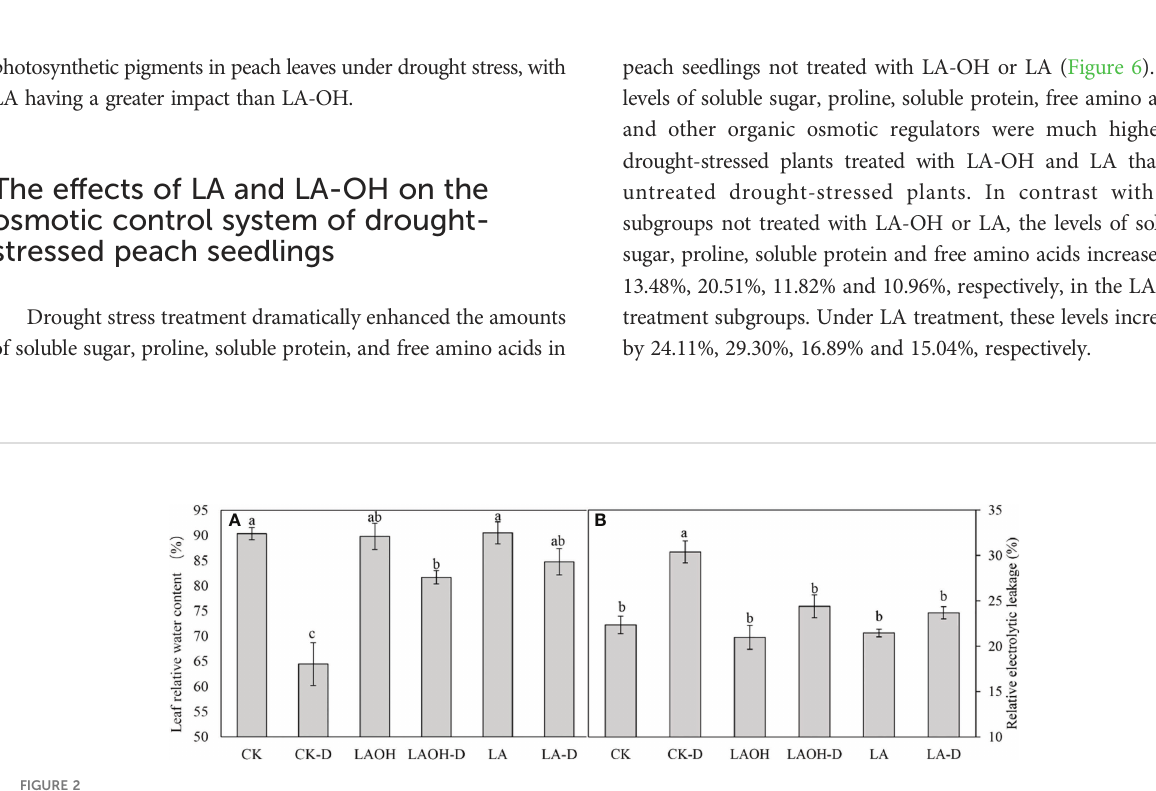
FIGURE 2 The effects of LA-OH and LA treatments on relative water content (A) and relative electrolyte leakage (B) in leaves under control and drought circumstances are shown in the graphs. The values represent the SD of the mean of three replicates. Duncan ’ s test and ANOVA were used. Signi fi cant differences (P < 0.05) are indicated by different